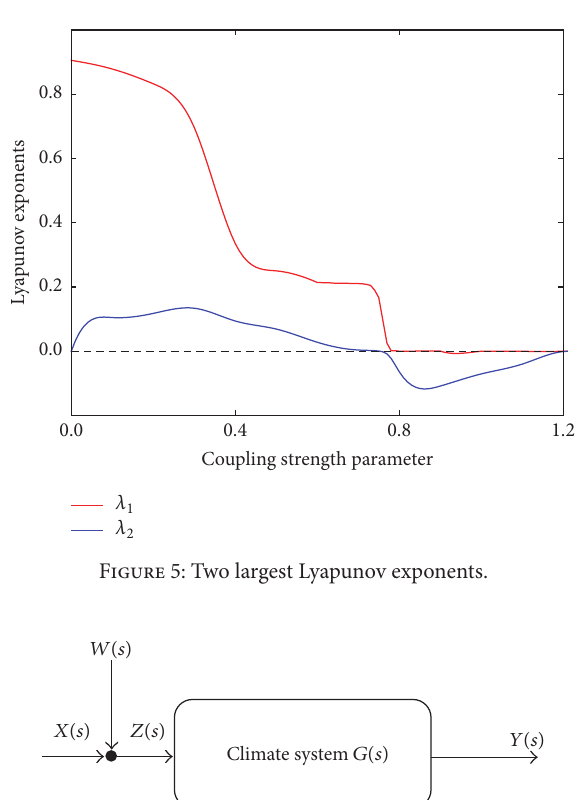
Figure 6: Block diagram for weather and climate manipulation.